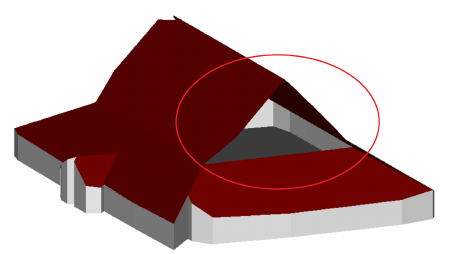
Figure 12. Example of a medium-complexity CityGML building model generated from M_HERACLES roof models. Notice the hole on the model as pointed by the red